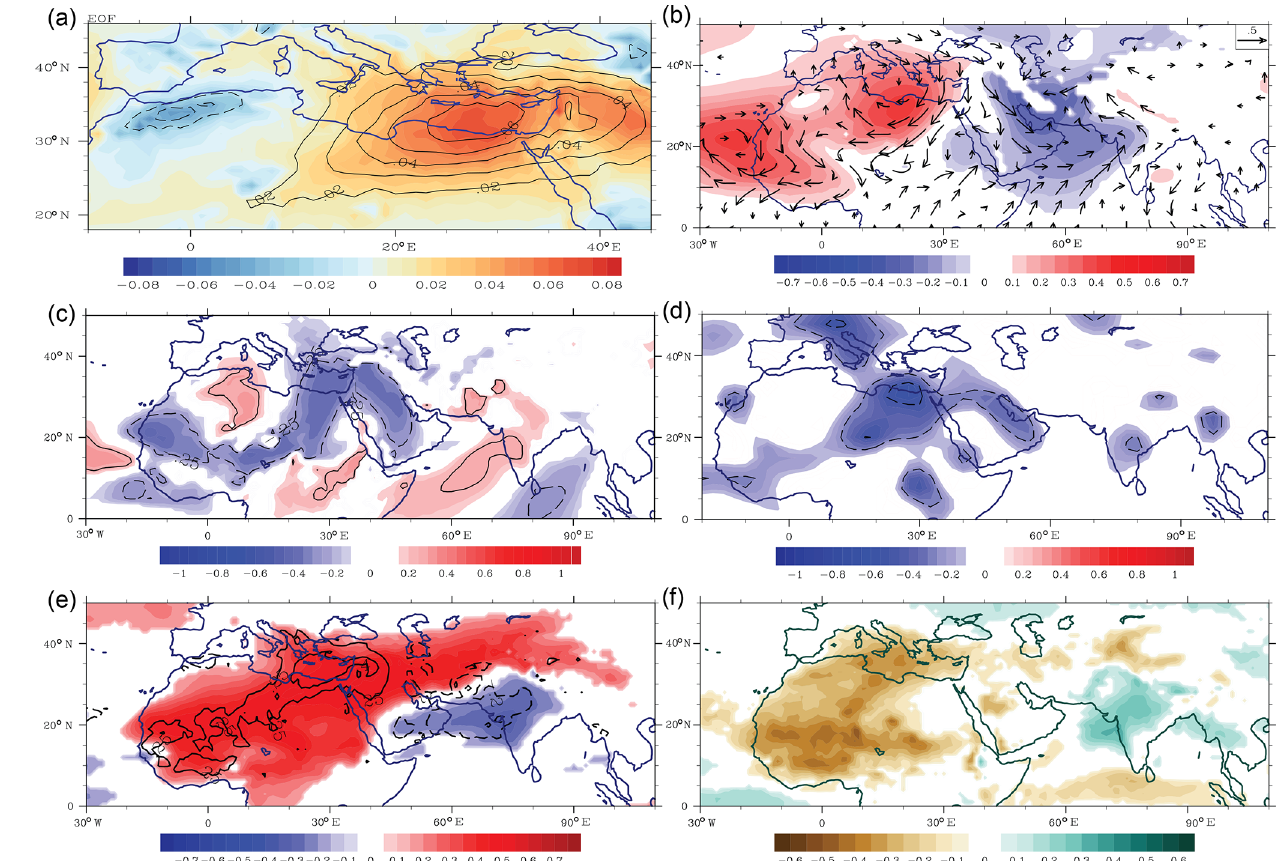
Figure 6. (a) First EOF of the vertical velocity at 500hPa (EOF1 ω , shaded) and at 300hPa (contours), derived for each level separately and from the monthly means of July in the CTRL run. The time series of the EOF1 ω at 500hPa are correlated with (b) geopotential height (shaded), the u and v components (shown as vectors) at 850hPa, (c) meridional wind at 850hPa, (e) outgoing longwave radiation (shaded), ω at 500hPa (contours: − 0 . 2, 0.2, 0.4), and (f) precipitation. (d) Correlations derived between the observed (NCEP) ω at 500hPa over the eastern Mediterranean region (32–34 ◦ N, 25–30 ◦ E) and the meridional wind at 850hPa. Correlations shown for (b) , (c) , (e) , and (f) at the 1% level, as well as for (d) at the 10% significance